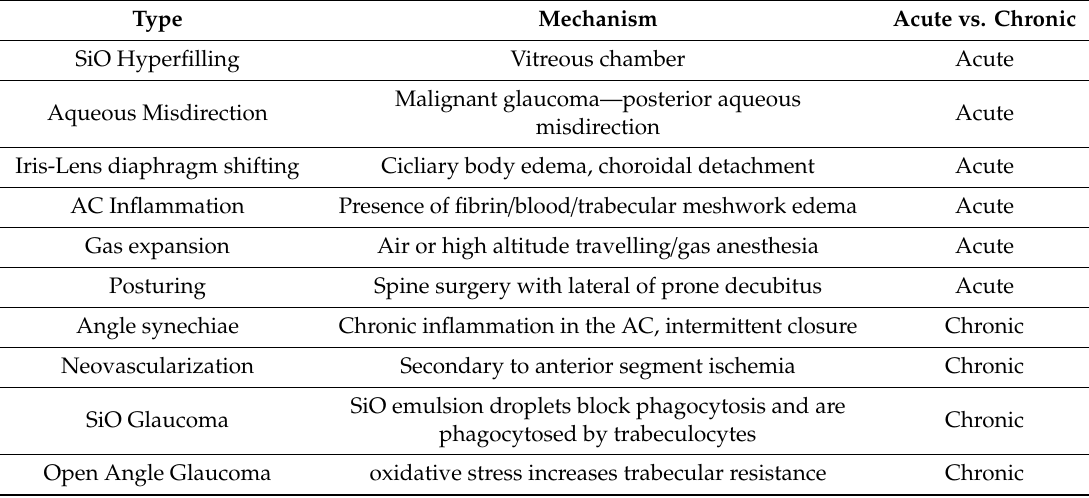
Table 1. Most frequent types and mechanism of intraocular pressure rise after pars plana vitrectomy. Type Mechanism Acute vs. Chronic SiO Hyperfilling Vitreous chamber Acute Malignant glaucoma—posterior aqueous Aqueous Misdirection Acute misdirection Iris-Lens diaphragm shifting Cicliary body edema, choroidal detachment Acute AC Inflammation Presence of fibrin / blood / trabecular meshwork edema Acute Acute Spine surgery with lateral of prone